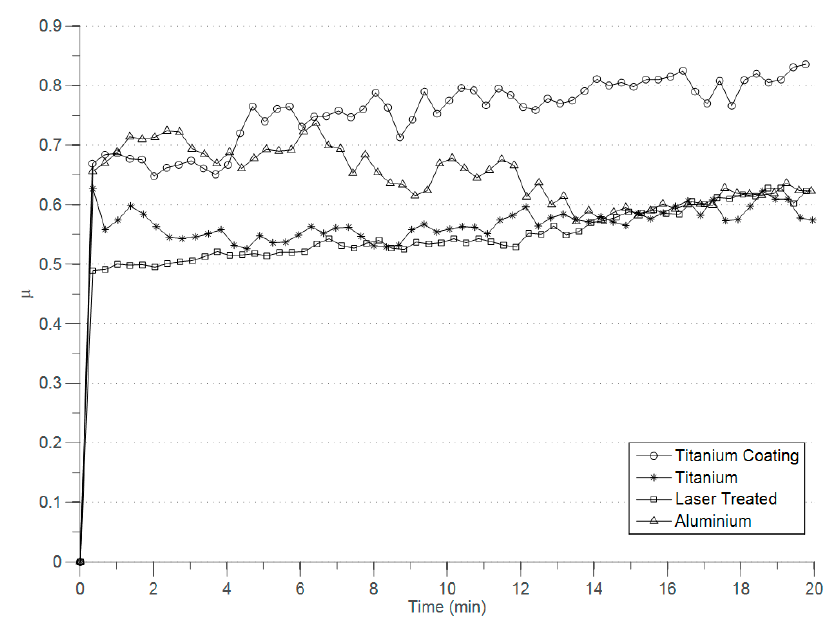
Figure 5. Evolution of friction coefficients for the processed plates with time.